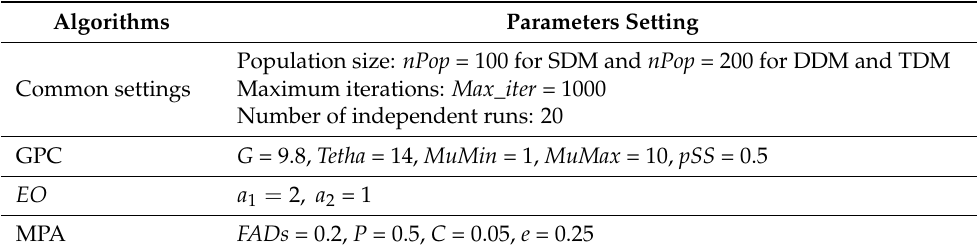
Table 6. Calculated parameter in case of the SDM obtained by the proposed algorithm and other recent techniques.